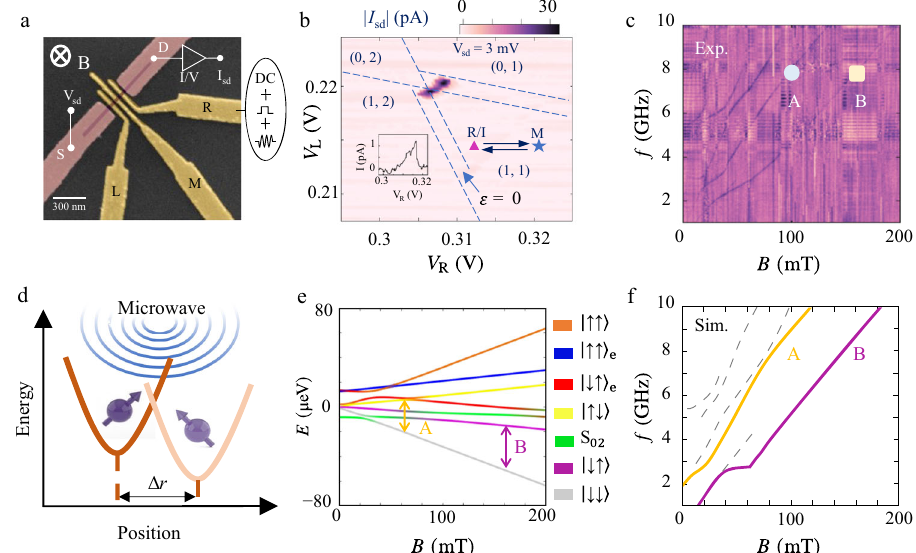
Fig. 1 Experimental setup and EDSR spectrum. a Scanning electron microscope image of the DQD device. Magentas metals are ohmic contacts while gates used to tune different potentials of DQDs are highlighted with yellow (L, M, and R). Gate L (R) produces the con fi nement potential for the left (right) dot. The tunnel coupling between the two dots is controlled by gate M. Microwave pulses are applied via gate R. b A conductance triangle of the DQD at V sd = 3 mV. Due to the weak signal of the small current, we mark the transitions of the triangle by blue dashed lines while the arrow indicates the position of the detuning ε = 0 (the energy difference between the left dot and the right dot) at the base line of the triangle. A suppressed current of ~1 pA is observed, which can be lifted by spin resonance. Points R, I, and M mark the readout, initialization and manipulation positions respectively. Inset: a line trace at V L = 0.215 V. c EDSR spectrum, measured by applying a continuous microwave with a power of − 15 dBm at the point R/I. The circle and square symbols show the working points for subsequent experiments, corresponding to a Larmor frequency ~8 GHz. d Schematic of spin-orbit-coupling-mediated spin fl ip: the microwave electric fi eld generated by the gate creates oscillatory displacements of the hole wave function ( Δ r ) and its energy. As described in our model, Δ r makes contribution to the energy shift mediated by the spin-orbit coupling Δ so . Such orbital dynamics lead to spin fl ip with the help of SOI. e Other related resonances are colored in grey in f (see details in Supplementary Note 2, EDSR spectrum). f Calculated EDSR spectrum from our effective two-hole model with g -factors of left and right dot of g L = 7 and g R = 3.95. The two highlighted resonances (purple, yellow) correspond to spin- fl ips between| ↓↓ 〉 and | ↓↑ 〉 /| ↑↓ 〉 , indicated by the arrows in the energy level diagram e